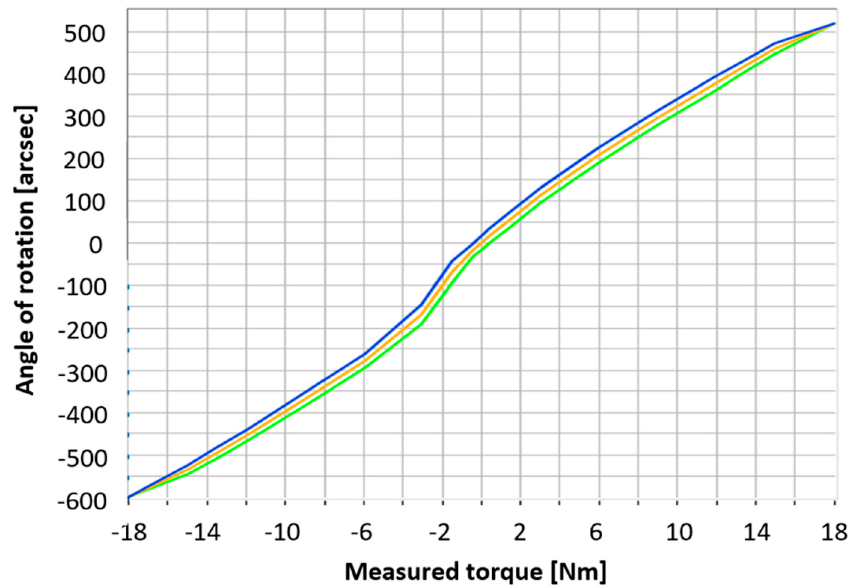
Figure 19. Course of the hysteresis curve BR TS 050-63, s/n.1911.